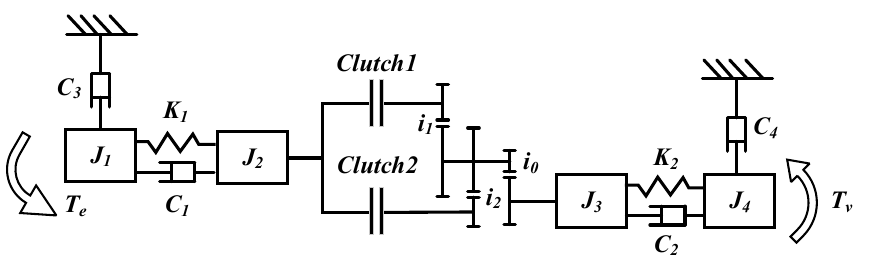
Figure 2. The simpli fi ed dynamics system model.